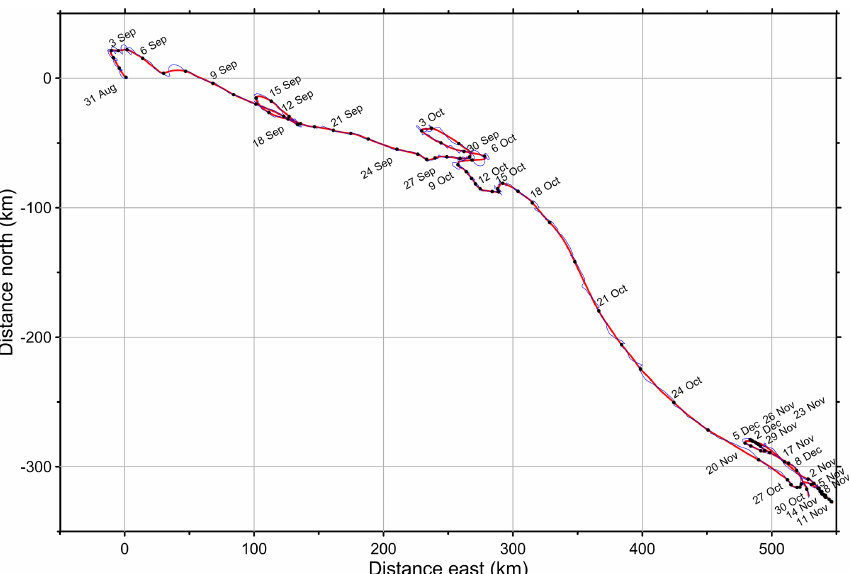
Figure 6. Progressive vector of ice drift in the Penny Strait from late August until mid-December 2009. Dots on the de-tided (red) curve are at daily intervals. Ice above the mooring became fast on 9 December.